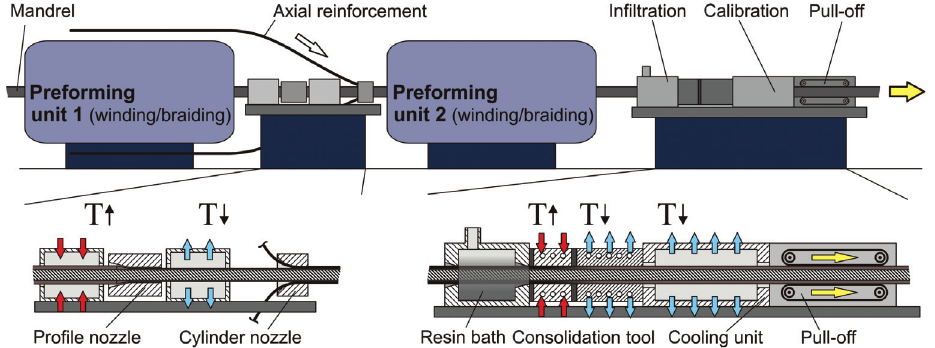
Figure 8 Process principle for a continuous pultrusion of profiled driveshaft